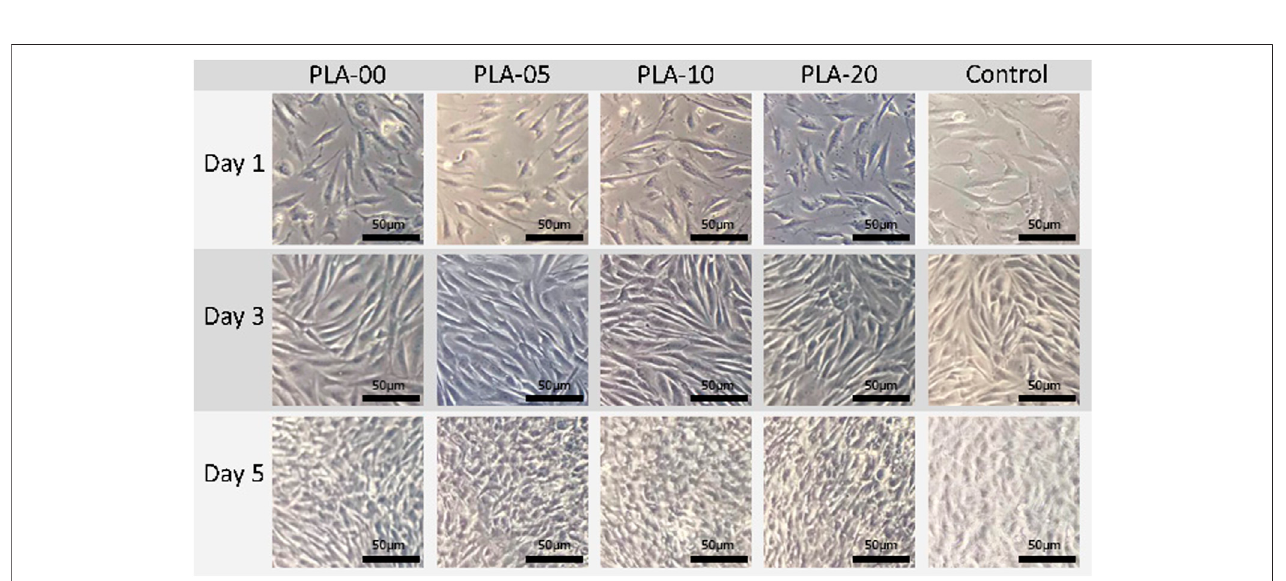
FIGURE 6 | FTIR spectra of PLA alone and with different β -TCP contents.